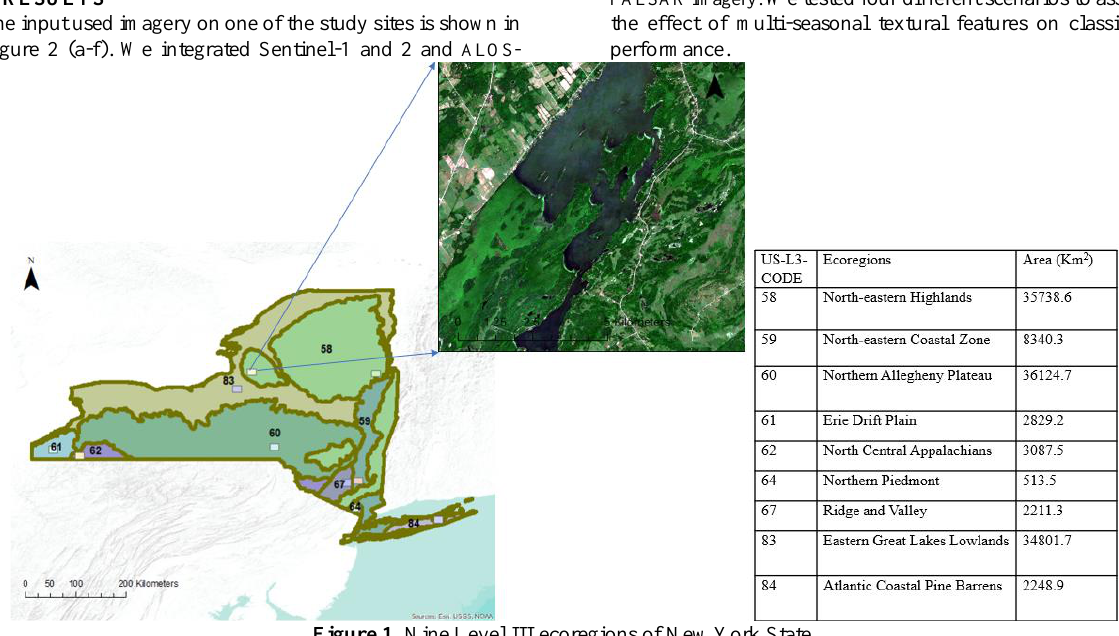
Figure 1. Nine Level III ecoregions of New York